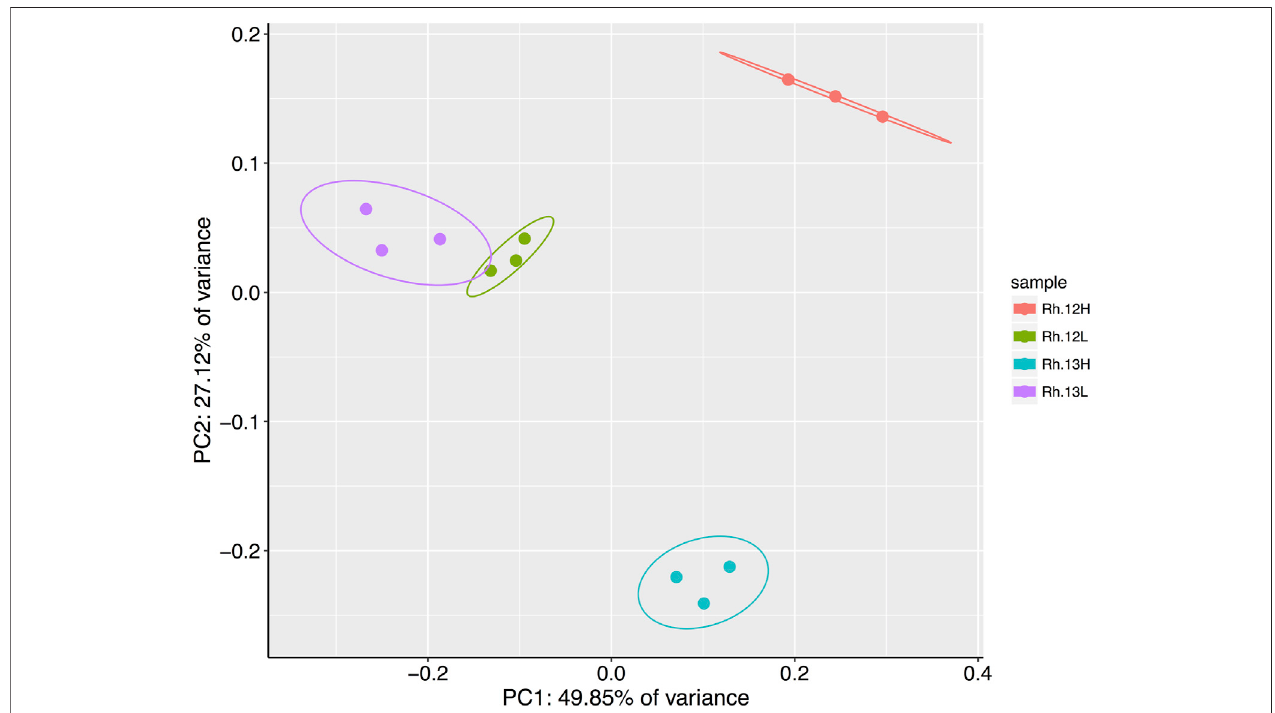
FIGURE 4 | Results of a principal coordinates analysis of Bray-Curtis dissimilarities between bacterial genera present in the heavy (H) and light (L) buoyant density fractionsofrhizospheresamples.Samplesweretakenfromplantsincubatedundereither 12 CO 2 (12L,12H)or 13 CO 2 (13L,13H)treatments( N (cid:2) 3replicateplantsunder each treatment). Principle Component 1 and 2 explain 49.85 and 27.12% of the variance in Bray – Curtis dissimilarities, respectively, between fraction types. Ellipses represent 95% con fi dence